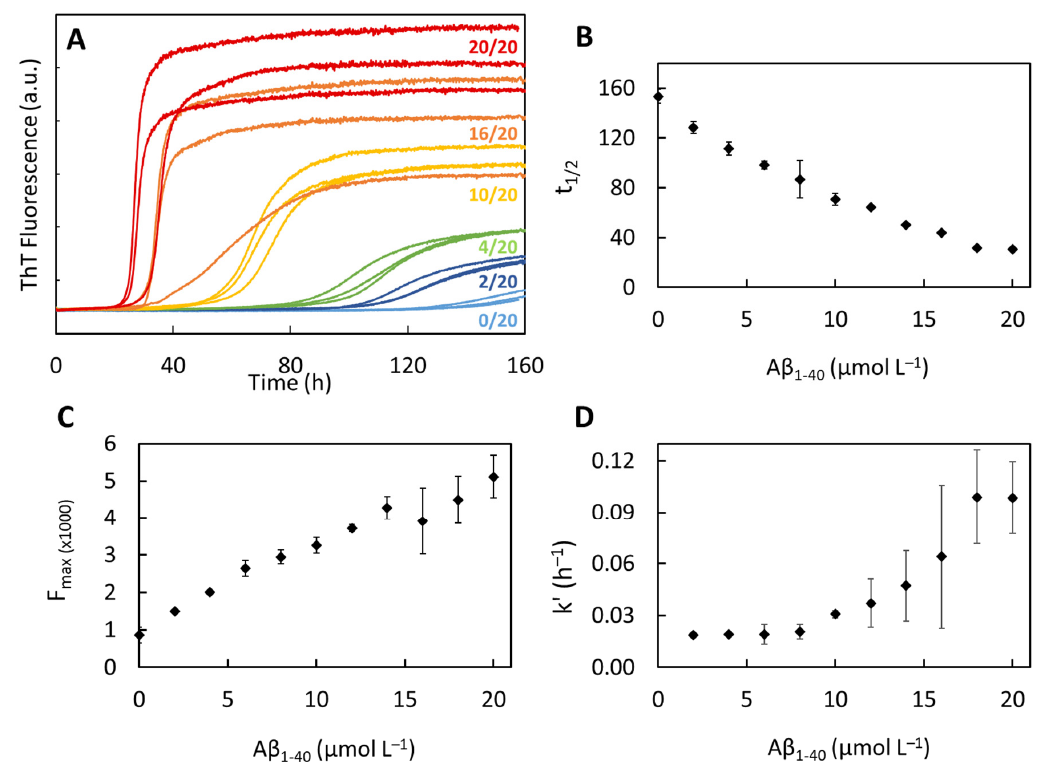
Figure 5. Kinetic monitoring of A β 1–40 and ox A β 1–40 co-assembly using ThT fluorescence as a function of addition of A β 1–40 to [A β 1–40 ] = 20 µ M. Curves are shown as triplicate. All curves [ ox A β 1–40 ] = 20 µ M + [A β 1–40 ] = 0 µ M (blue), 2 µ M (dark blue), 4 µ M (green), 10 µ M (yellow), 16 µ M (orange), 20 µ M (red) ( A ). From experiment N ◦ 1: HEPES buffer 50 mM, [NaCl] = 65 mM, pH 7.4. Y-axis corresponds to ThT fluorescence in arbitrary unit (a.u.); data are directly comparable between them (same y-scale). ( B – D ) Average t 1/2 , F max and k’ values as a function of the [A β 1–40 ] with ox A β ox A β µ M). Data from curves of Figure 5 and Figure 1–40 present ([ 1–40 ] = 20